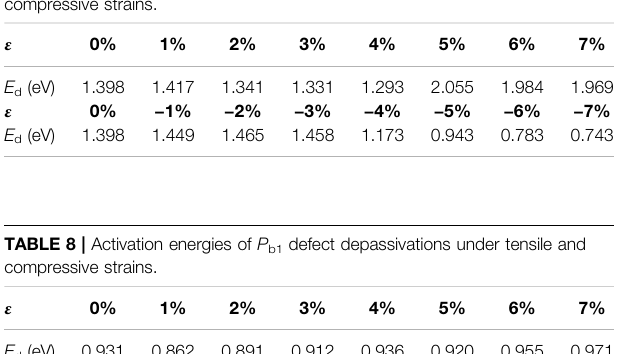
Frontiers in Materials |